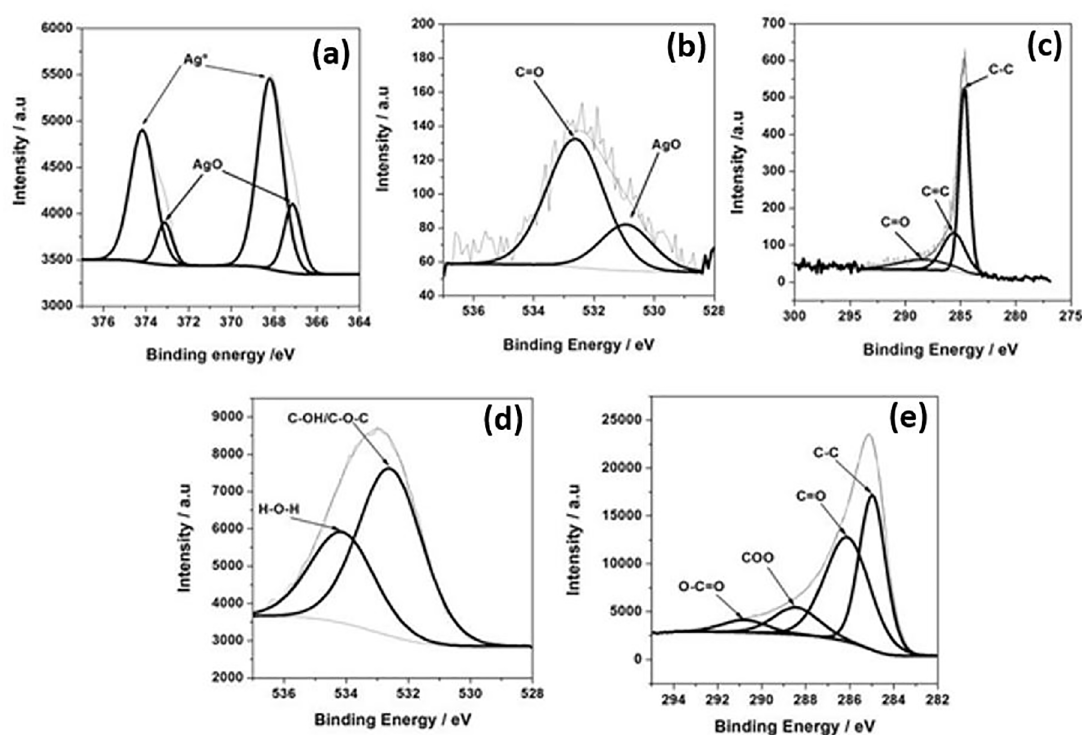
Figure 3. Deconvoluted XPS spectra of: (a) O 1s core level spectrum of Ag@ACF, (b) C 1s core level spectrum of Ag@ACF, and (c) Ag 3d core level spectrum, (d) O 1s core level spectrum of ACF, (e) C 1s core level spectrum of ACF.